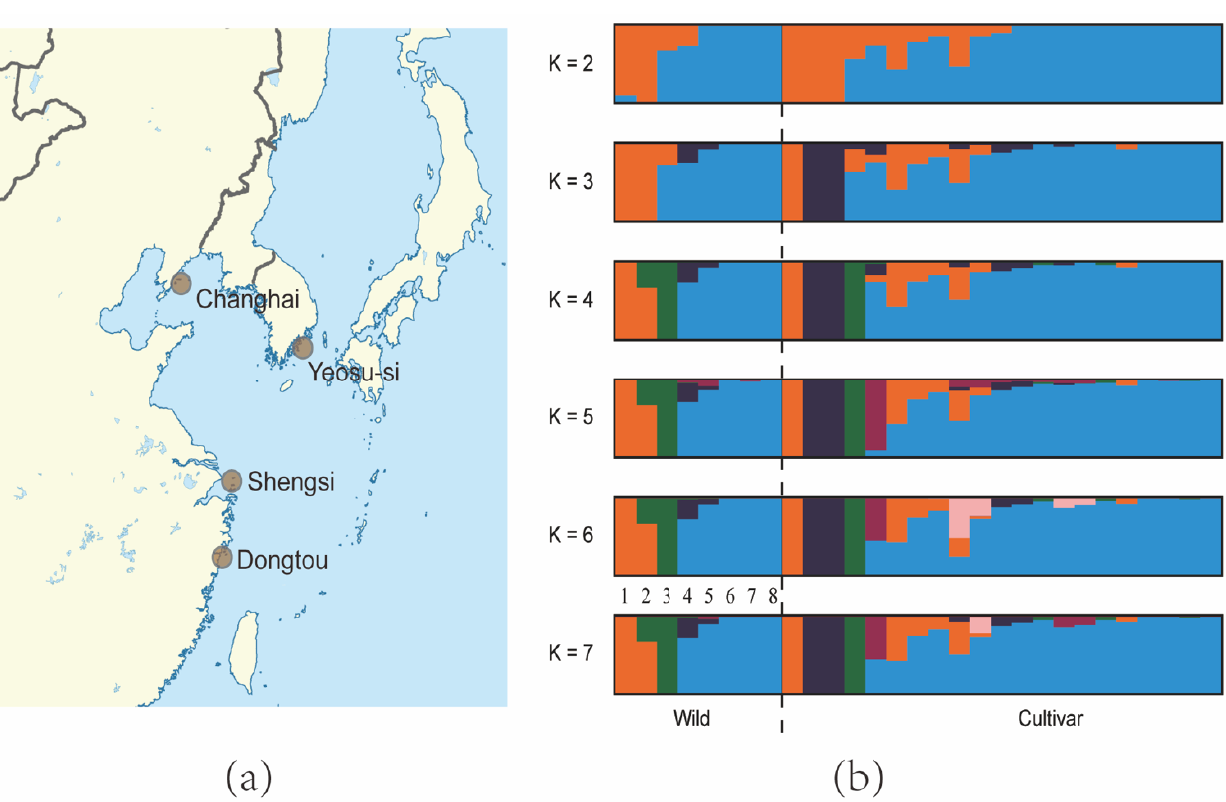
Figure 1. The population information of cultivated and wild S. fusiforme. ( a ) Geographical distribution of the collected S. fusiforme . The brown dots show the location of each sample site. Detailed information is listed in Table 1. ( b ) The STRUCTURE analysis for 29 cultivated and wild S. fusiforme . The abscissa represents each individual sample, and the ordinate represents the number of ancestors from 2 to 7. The number shown for wild is corresponding to the sample below: 1, Shengsi; 2 – 3, Changhai; 4 – 8, Yeosu-si. Table 1. Sample information of collected S. fusiforme for ddRAD-seq.